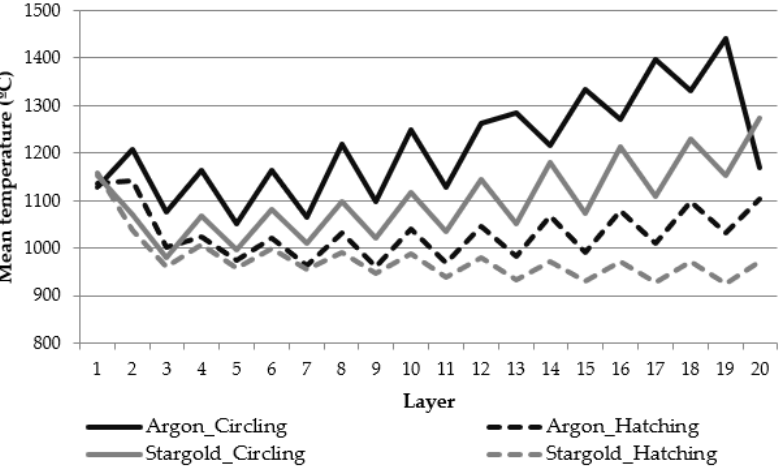
Figure 12. Mean melt pool temperature evolution in different layers of parts built with 30 L/min shielding flow rate.